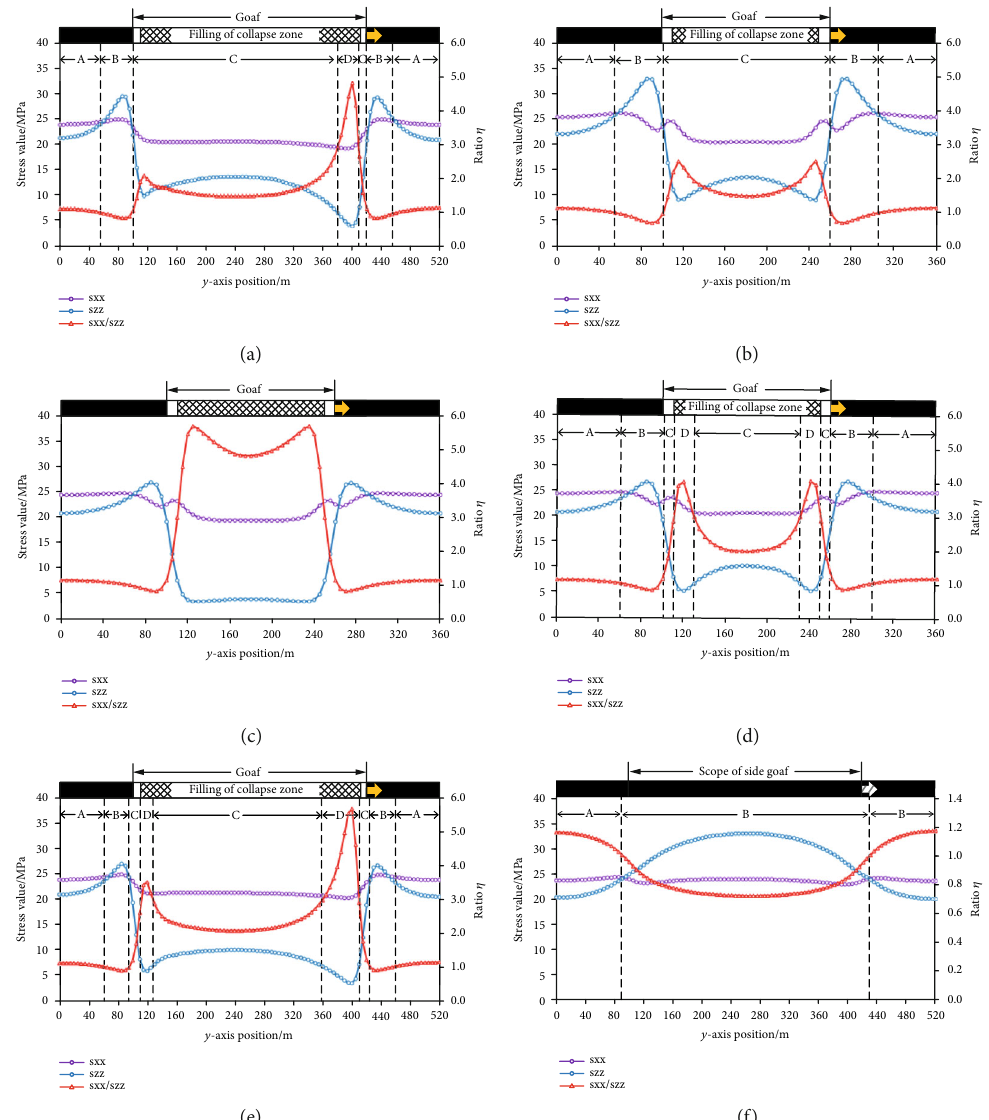
Figure 9: Stress value and its ratio at each monitoring line under the in fl uence of mining: (a) monitoring line 1; (b) monitoring line 2; (c) monitoring line 3; (d) monitoring line 4; (e) monitoring line 5; (f) monitoring line